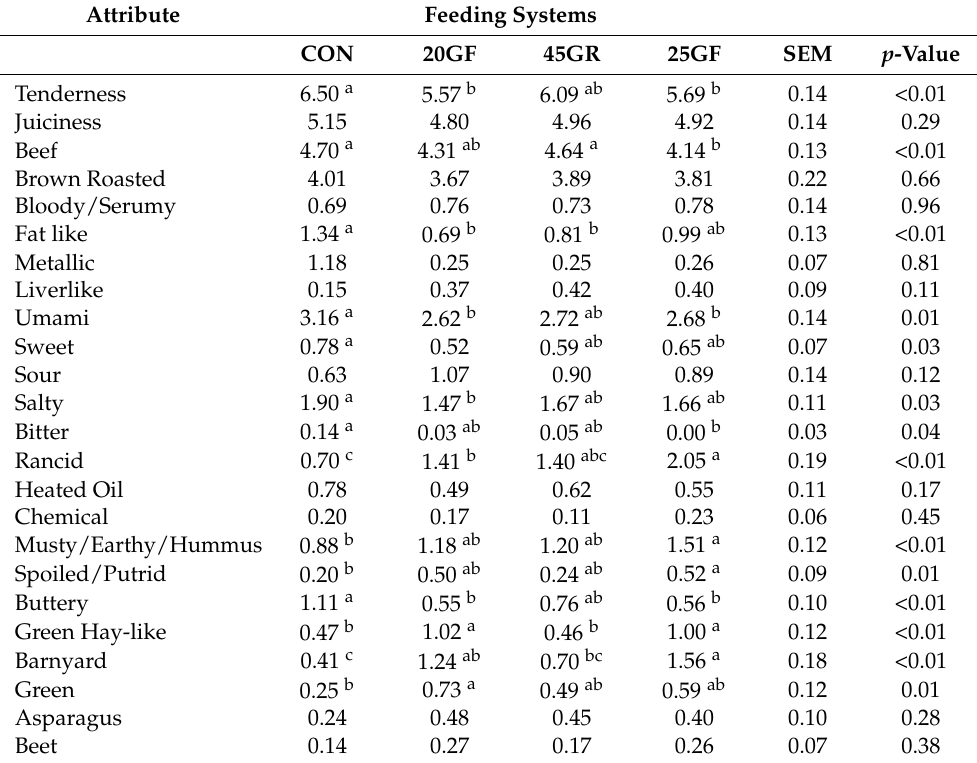
Table 4. Flavor profile of beef steaks from different grass and grain feeding systems 1 .